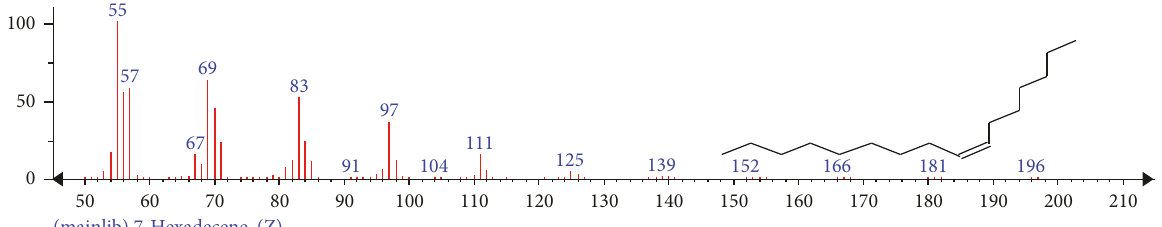
(Z)-50 60 (mainlib) 7-Hexadecene, Figure 20: Mass spectrum of compound 7-hexadecene, (Z)- of whole plant hexane fraction of Achillea wilhelmsii (WHFAW).